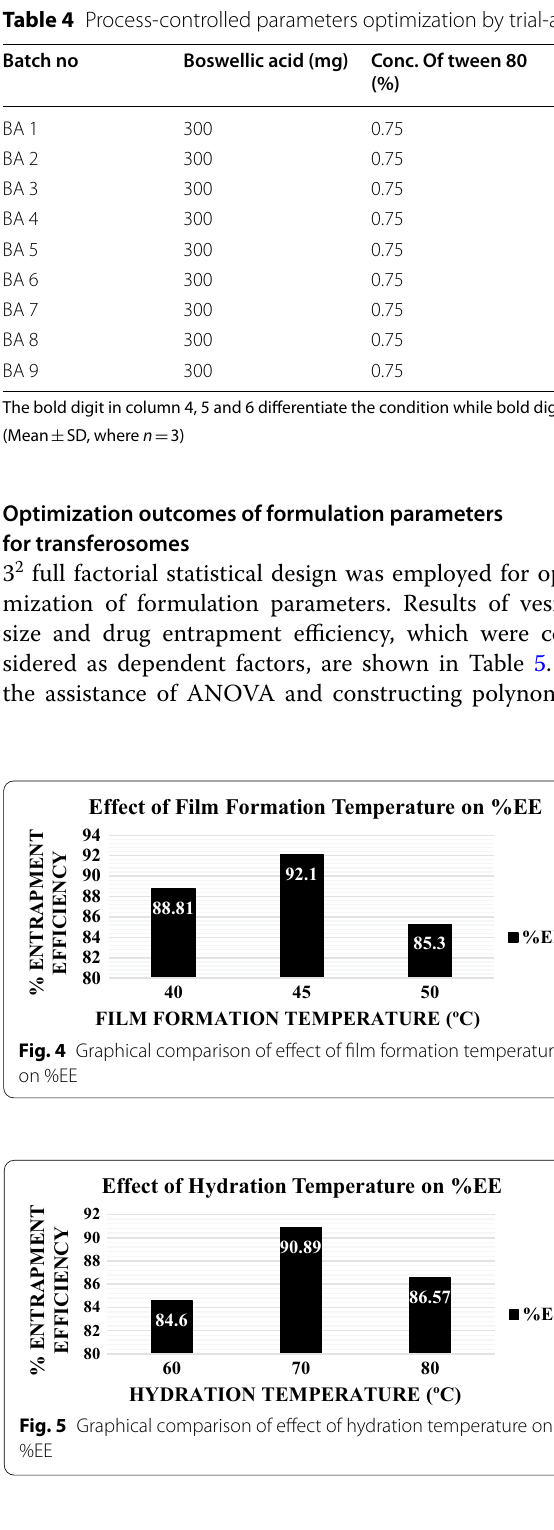
Table 4 Process-controlled parameters optimization by trial-and-error method